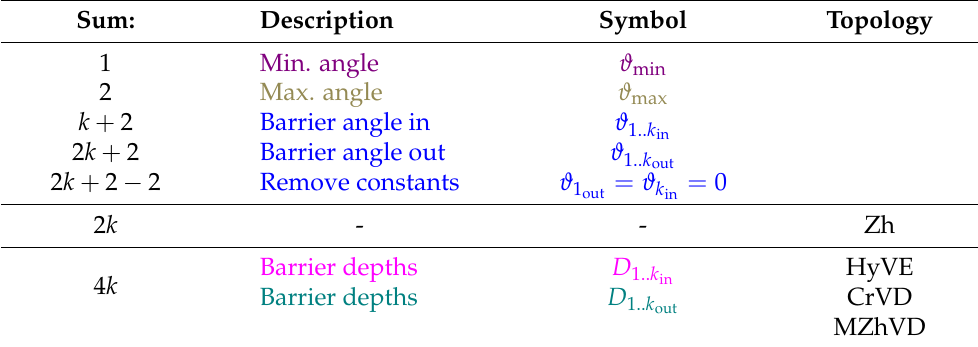
Table 3. Calculation of total parameter number. Color coding is according to Figure 4 variables.